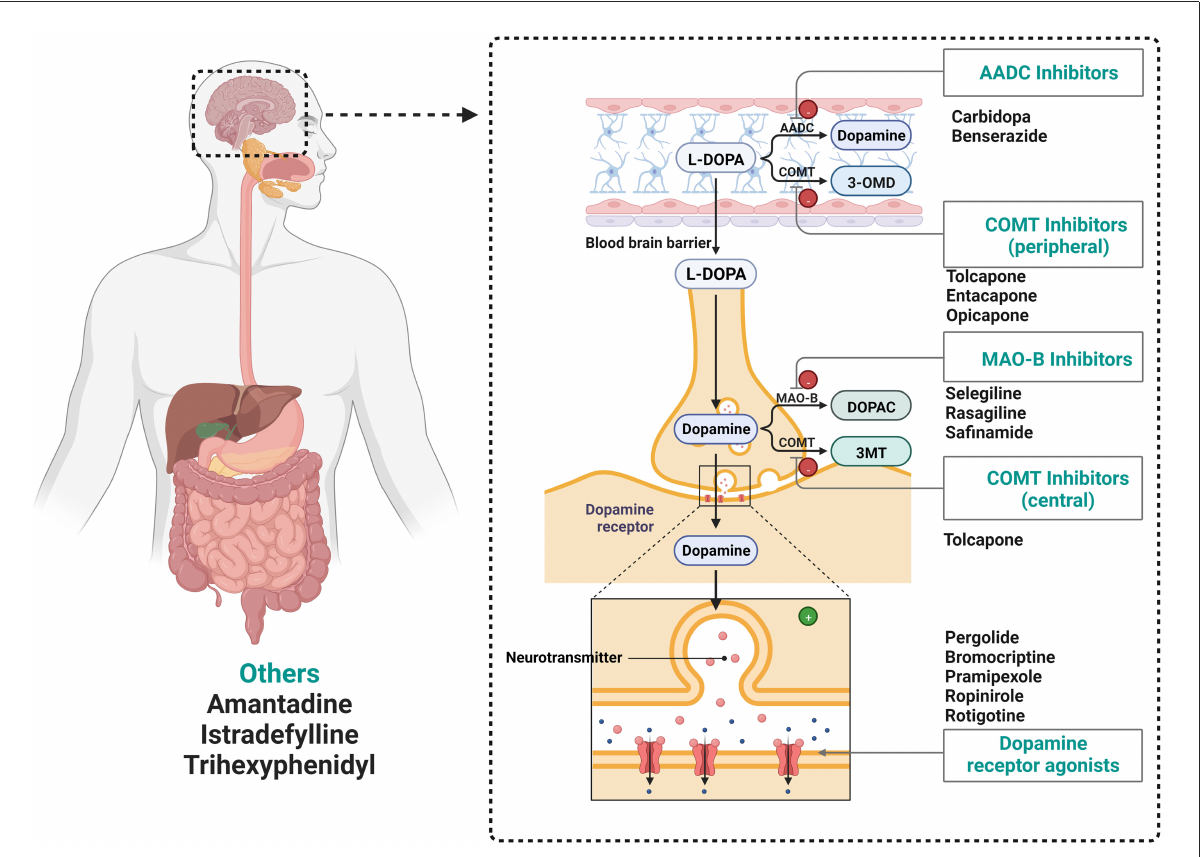
FIGURE1 Drugs utilized in the treatment of Parkinson’s disease. MAO-B, Monoamine oxidase-B inhibitors; COMT, catechol-O-methyl transferase inhibitors; L-DOPA, L-3,4-dihydroxyphenylalanine; AADC, amino acid decarboxylase (AADC, Dopa decarboxylase); DOPAC, 3,4-dihydroxyphenylacetic acid; 3-OMD, 3-O-methyl-dopa; 3-MT,